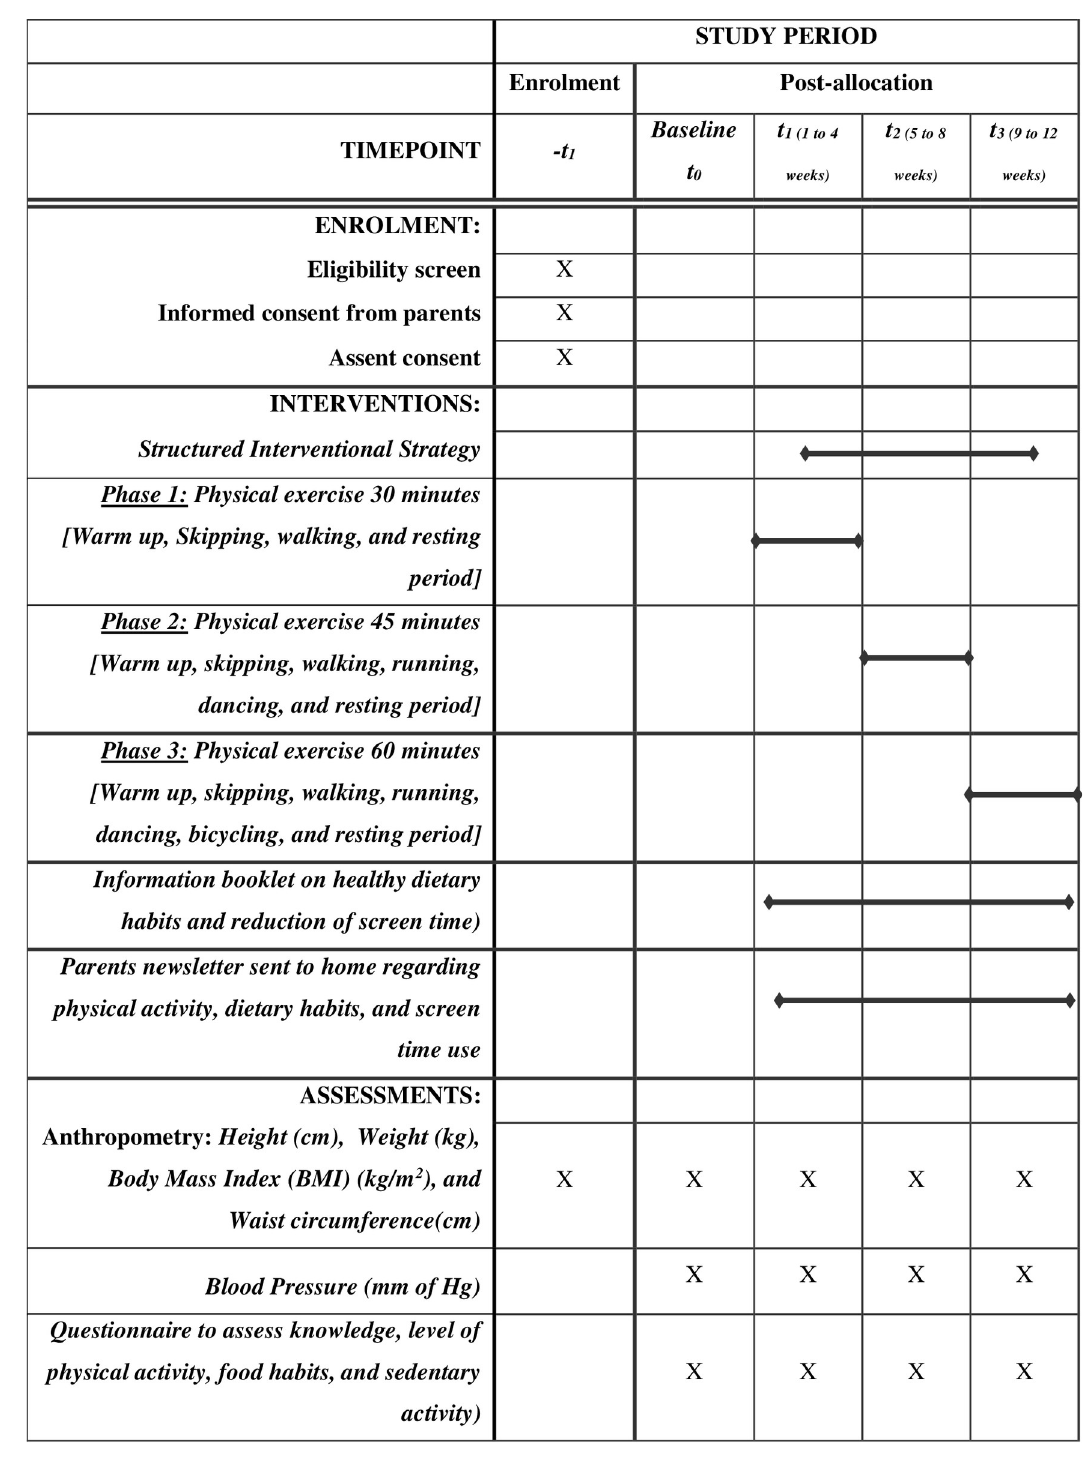
Fig 1. SPIRIT 2013: Schedule of enrolment, intervention, and assessment in the SISMA–PA pre-post time-series study. – t = timepoint for screening a study participants; t 0 = timepoint for baseline assessment; t 1 = phase1 intervention; t 2 = phase 2 intervention; t 3 = phase 3